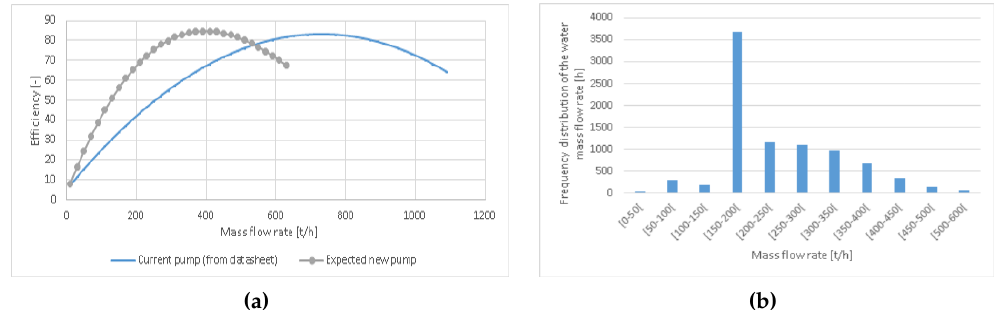
Figure 4. Pump characteristics. ( a ) Pump efficiency as a function of mass flow rate; and ( b ) frequency distribution of the pump use in function of the mass flow rate (based on one year).